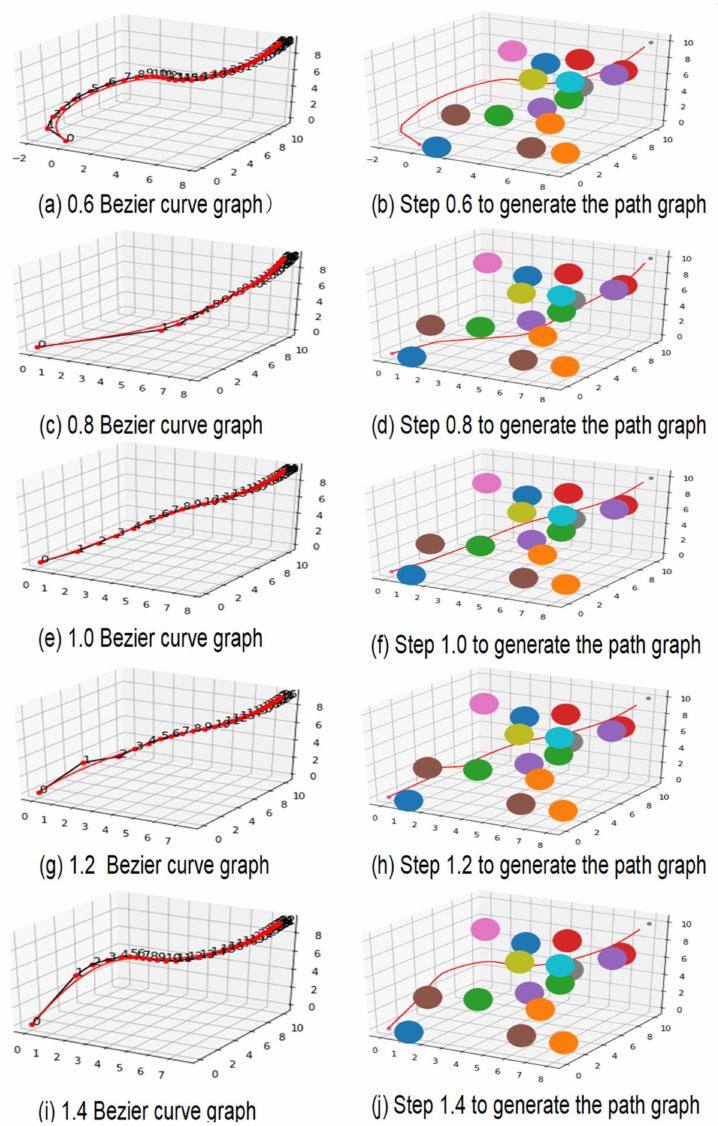
Figure 11. Comparison of hybrid algorithms with different step